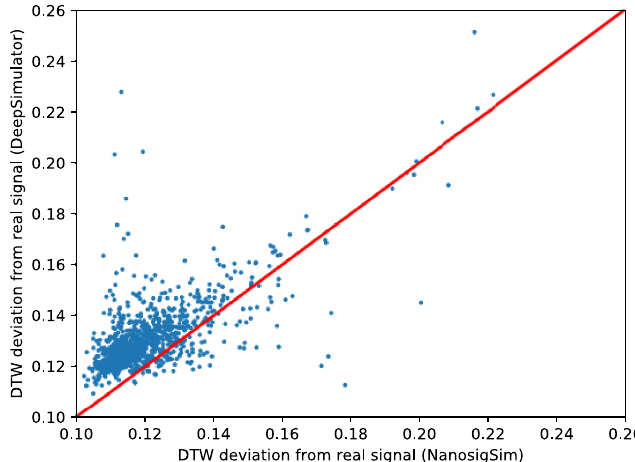
Figure 9. The similarity comparison between the two simulated signals and the real sequencing signal based on DTW distance. Any point above the red line means our simulation is better, whereas any point below means DeepSimulator is